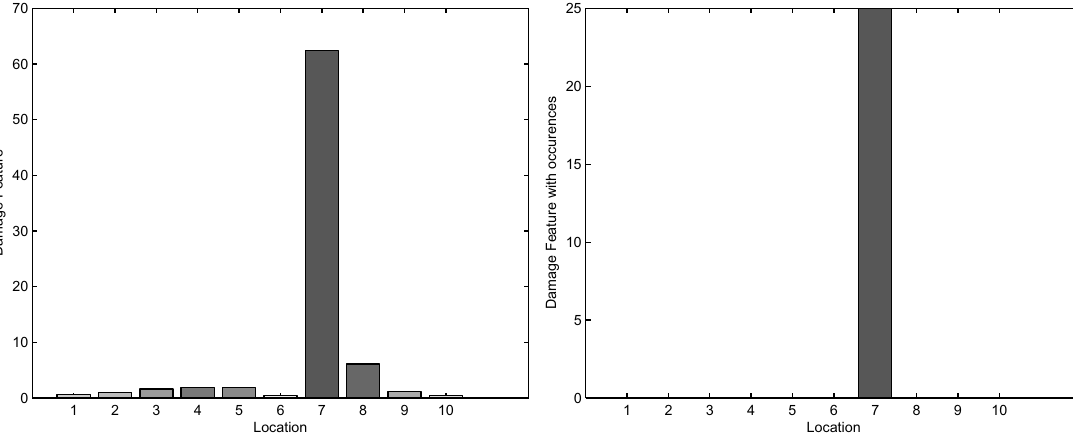
Fig. 34. Damage feature without and with occurrences for damaged structure and changing loading conditions, frequency range 83–86Hz.